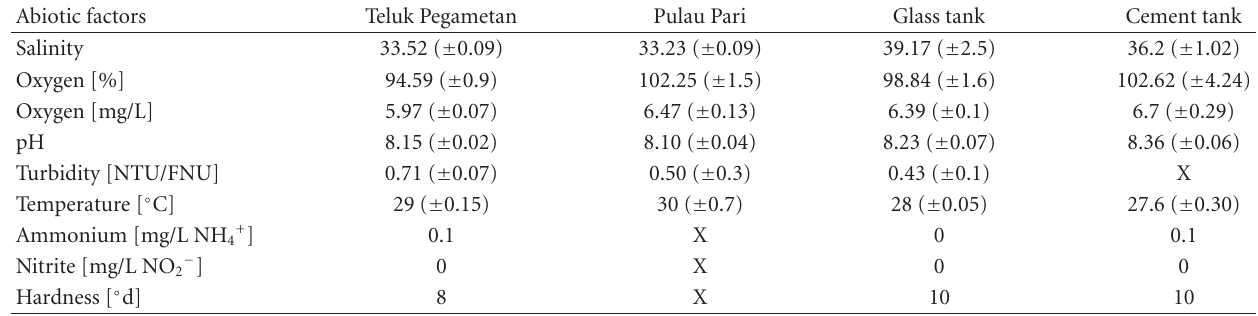
Table 3: Mean values for abiotic factors.